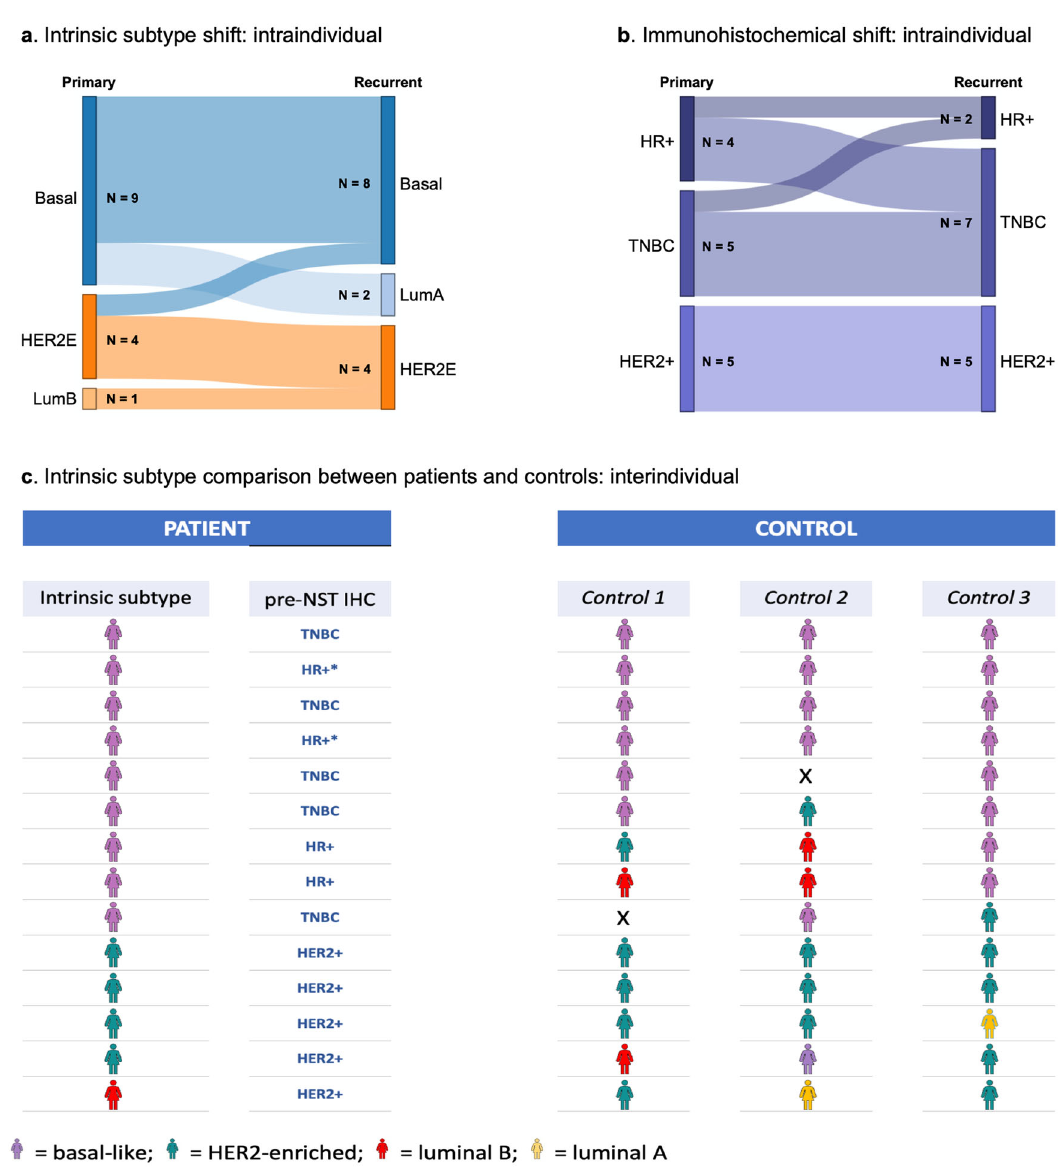
Fig. 2 Comparison of intrinsic subtype and immunohistochemistry between patients and controls. Shift in intrinsic subtype ( a ) and immunohistochemical classi fi cation ( b ) in between primary tumor and relapse in patients and comparison of intrinsic subtype of primary tumors between patients and matched controls ( c ). For interindividual analysis, patients and controls were matched by immunohistochem- istry. *Also gBRCA1 mt. Abbreviations: HER2 human epidermal growth factor receptor 2, HER2E HER2 expressing, HR hormone receptor, IHC immunohistochemistry, LumA luminal A, LumB luminal B, NST neoadjuvant systemic therapy, TNBC triple-negative breast